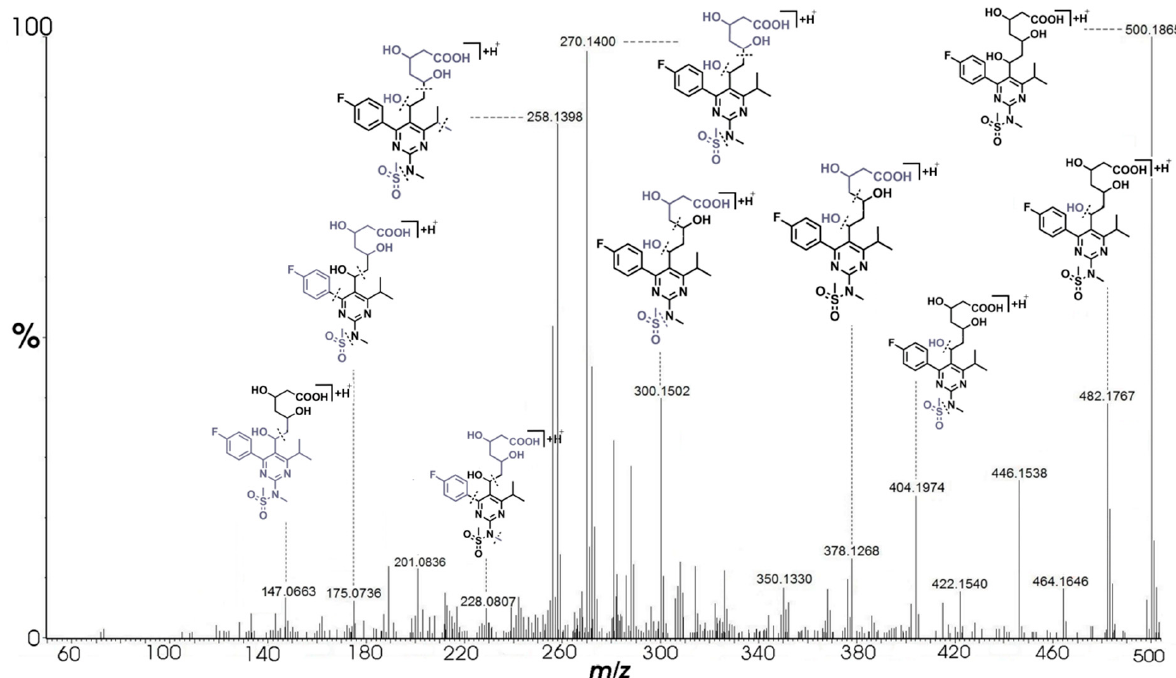
Figure 5. Fragmentation MS/MS spectra of product B.1 [M + H] + ion (precursor ion mass m/z 500.1865) obtained by using collision energy of 25 V.